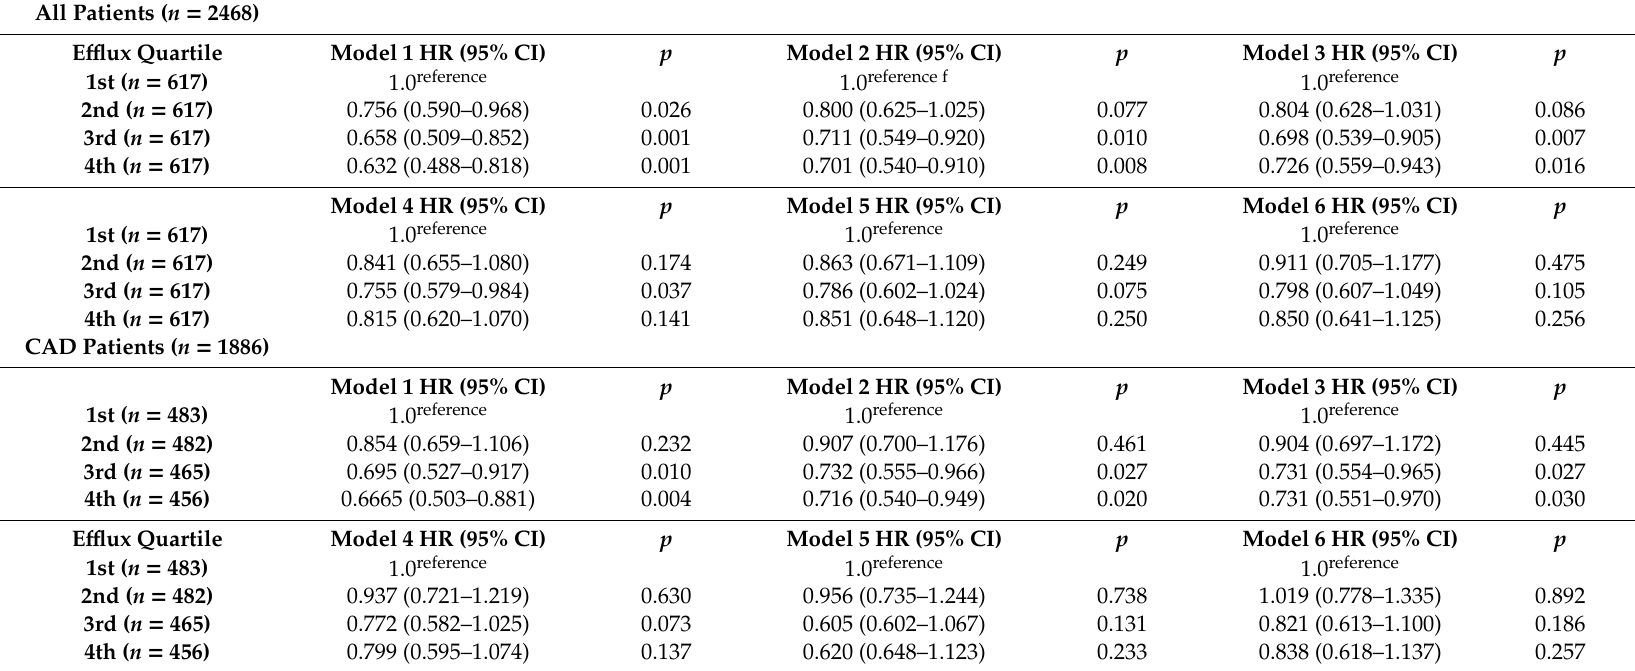
Table 2. Hazard ratio for cardiovascular death according to cholesterol e ffl